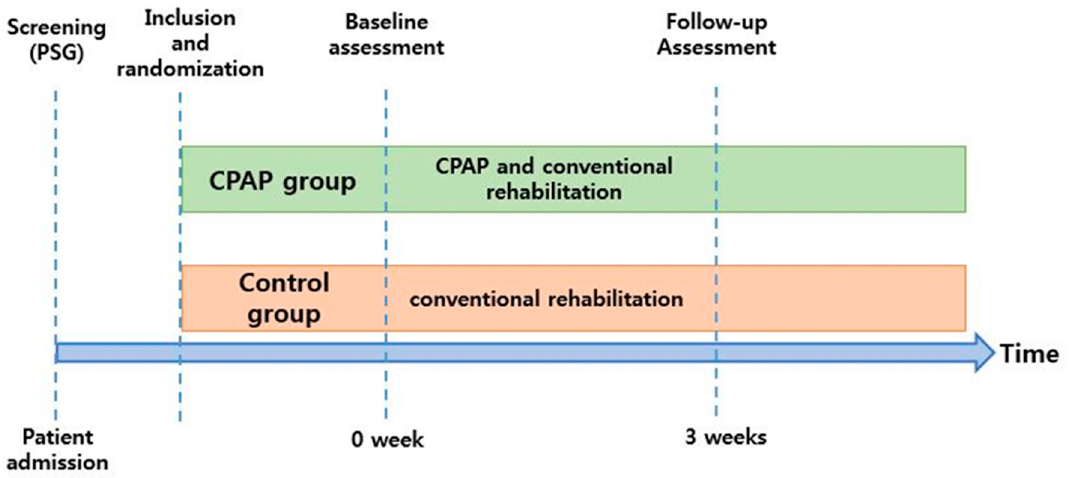
Figure 2. Study design. PSG, Polysomnography. Table 4. Comparison of daytime sleepiness index and polysomnographic data between CPAP and control group.